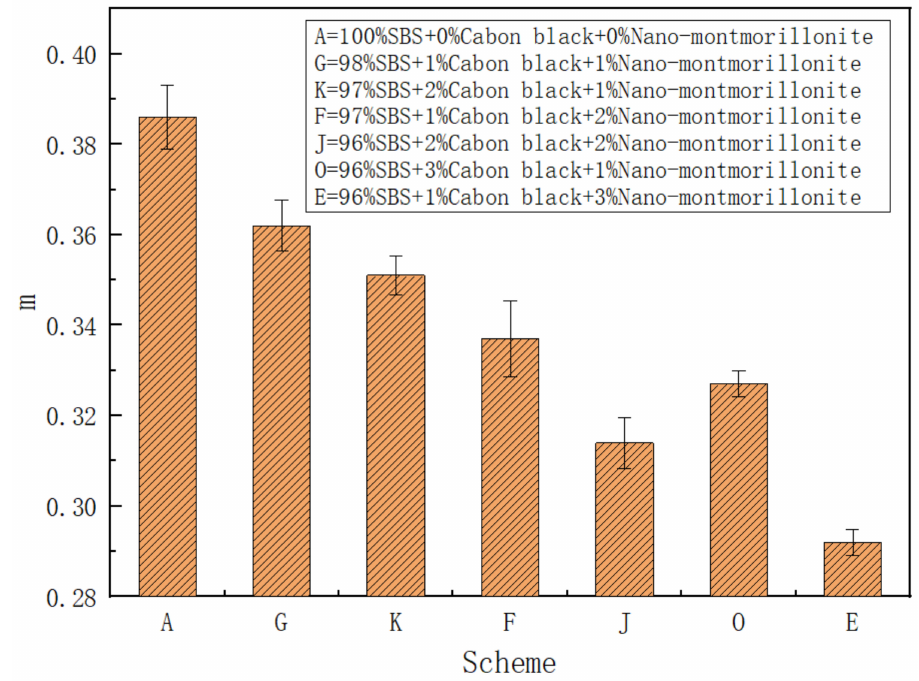
Figure 6. Low-temperature creep rates m of asphalt from different schemes.